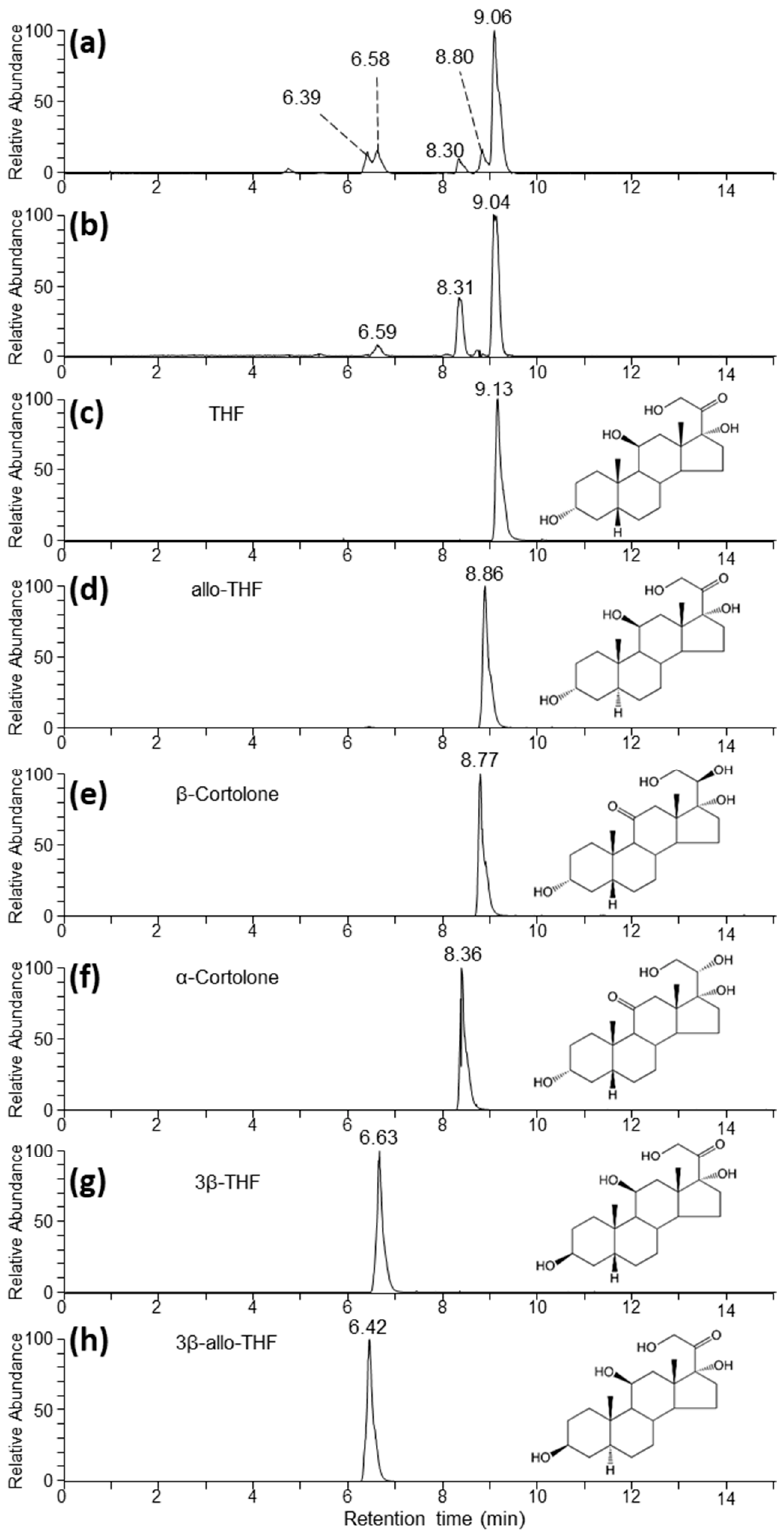
Figure 2. Extracted ion chromatograms (EICs) corresponding to the m/z of the formate adduct of THF, its isomers, and α - and β -cortolone under reverse phase chromatographic conditions. ( a , b ) correspond to representative AC samples from Harvey and Pixie, respectively, from timepoints that were high in feature 2 according to the untargeted analysis. ( c – h ) correspond to authentic standards as indicated.